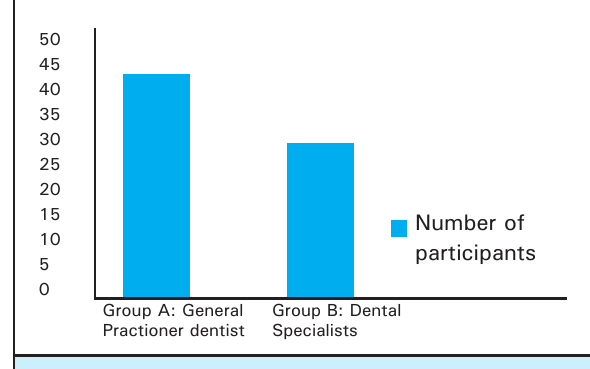
Figure 1. Total Number of participants and group division of the study.